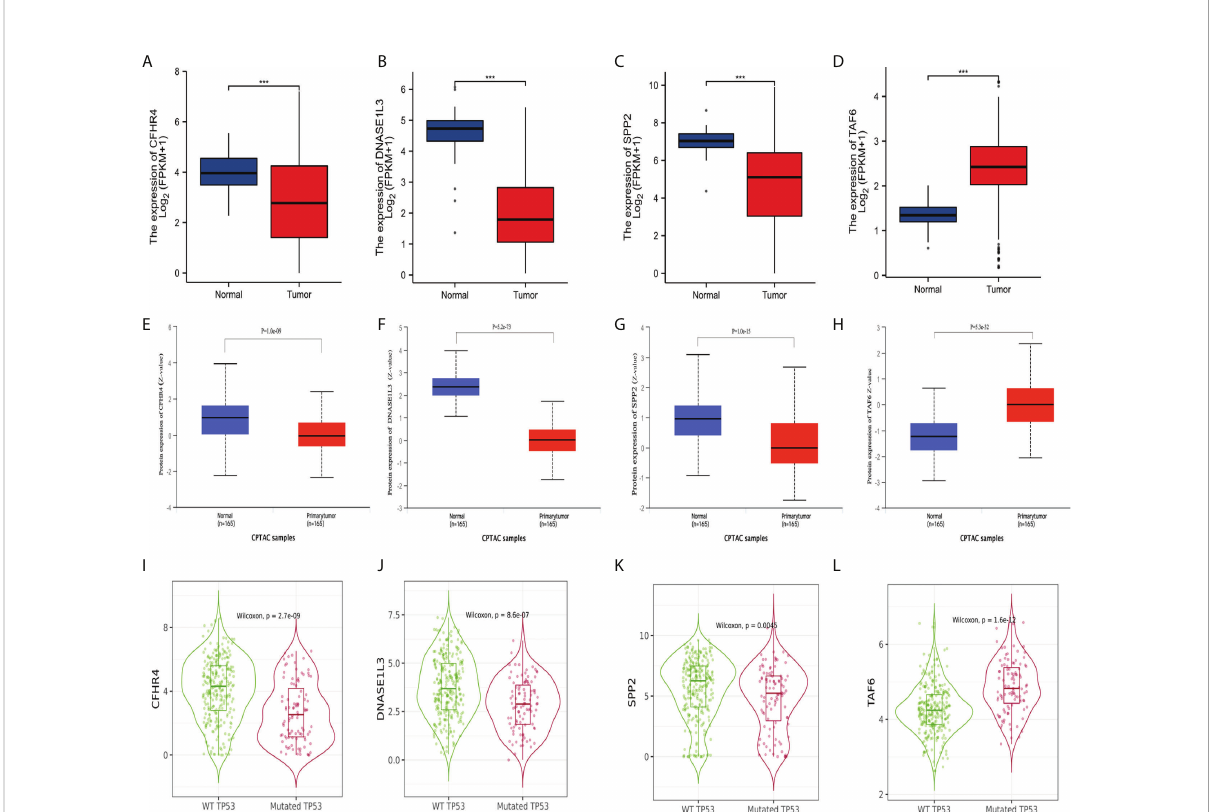
FIGURE 11 Differential expression of the signature genes. (A – D) Differential expression of CFHR4, DNASE1L3, SPP2, and TAF6 in adjacent non-tumor tissues and HCC tissues in the TCGA database. (E – H) Differential expression of CFHR4, DNASE1L3, SPP2, and TAF6 in adjacent non-tumor tissues and HCC tissues in the CPTAC dataset. (I – L) Differential expression of CFHR4, DNASE1L3, SPP2, and TAF6 of HCC patients in the wild TP53 group and the mutant TP53 groups.